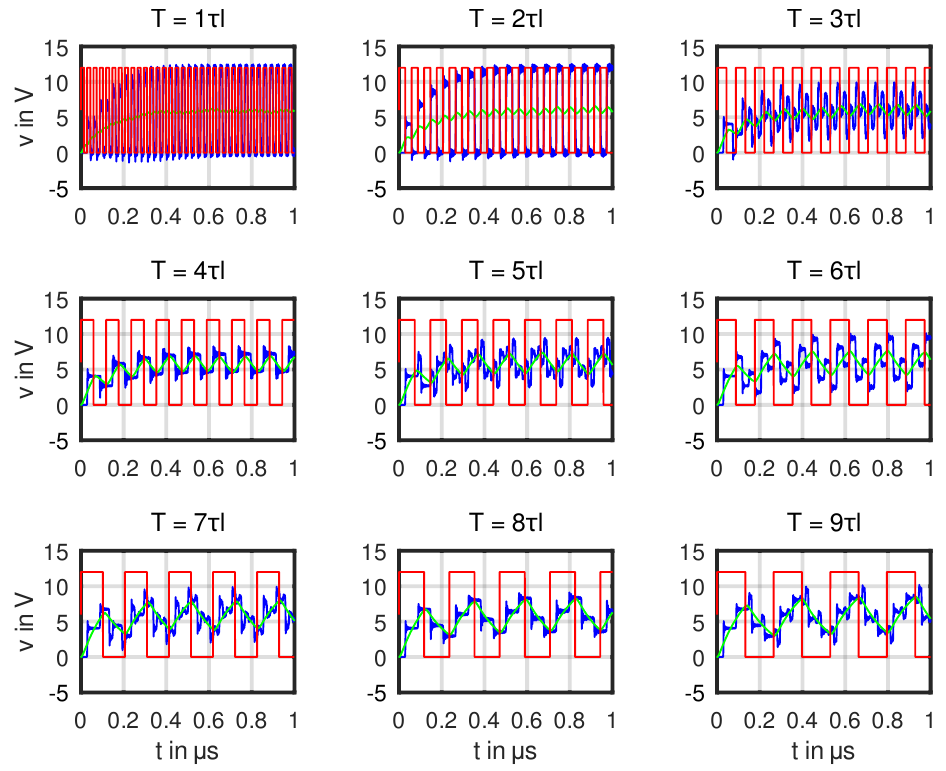
Figure 6. Transient voltages for PWM duty ratio d = 0.5 and different switching periods T : output voltage v ( t ) of the classical converter (green), output voltage v ( l , t ) on the right boundary of the distributed converter (blue), PWM input voltage